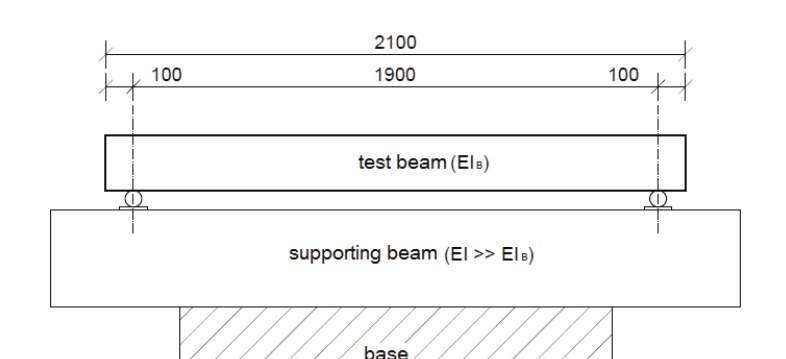
Fig. 4. Beam B-003